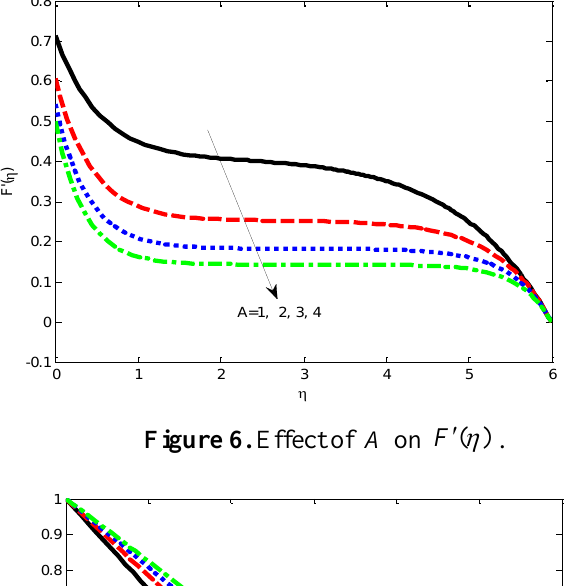
Figure 6. Effect of A on ( ) F  .